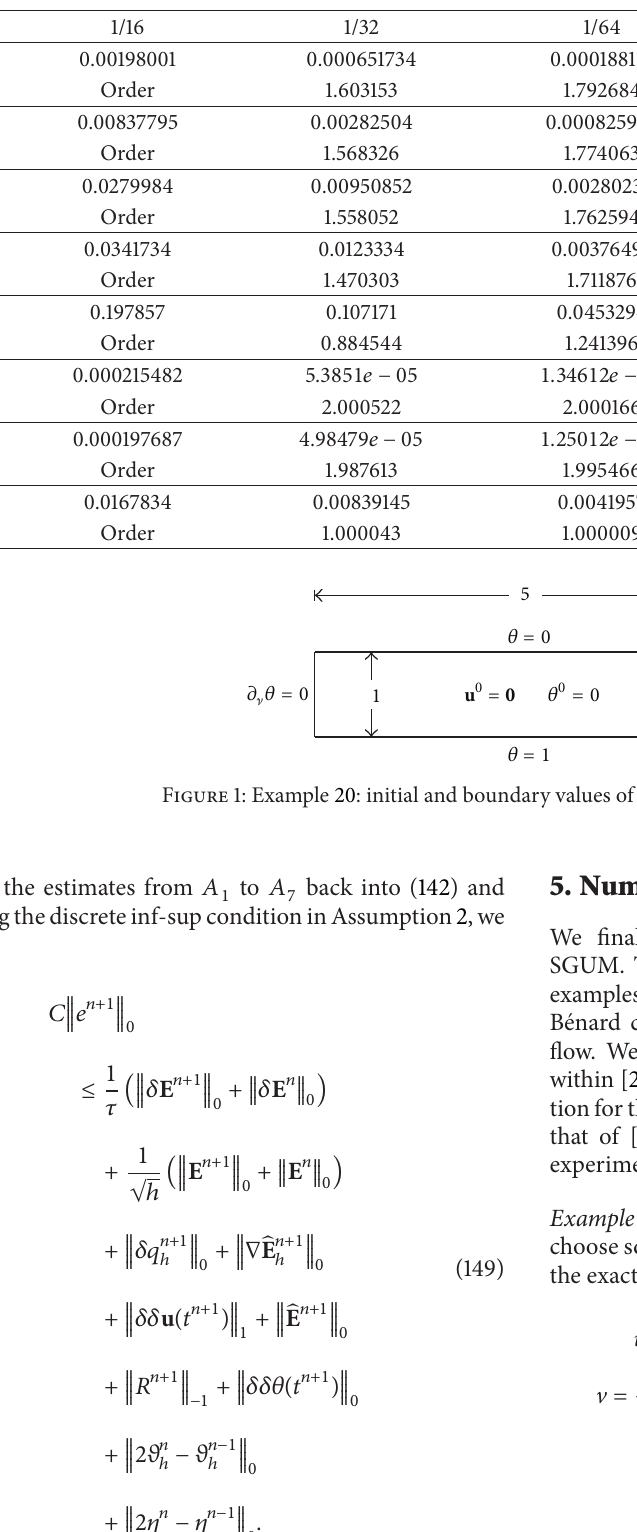
Table 1: Error decay for Algorithm 1 with 𝜏 = ℎ and 𝜇 = 1 .